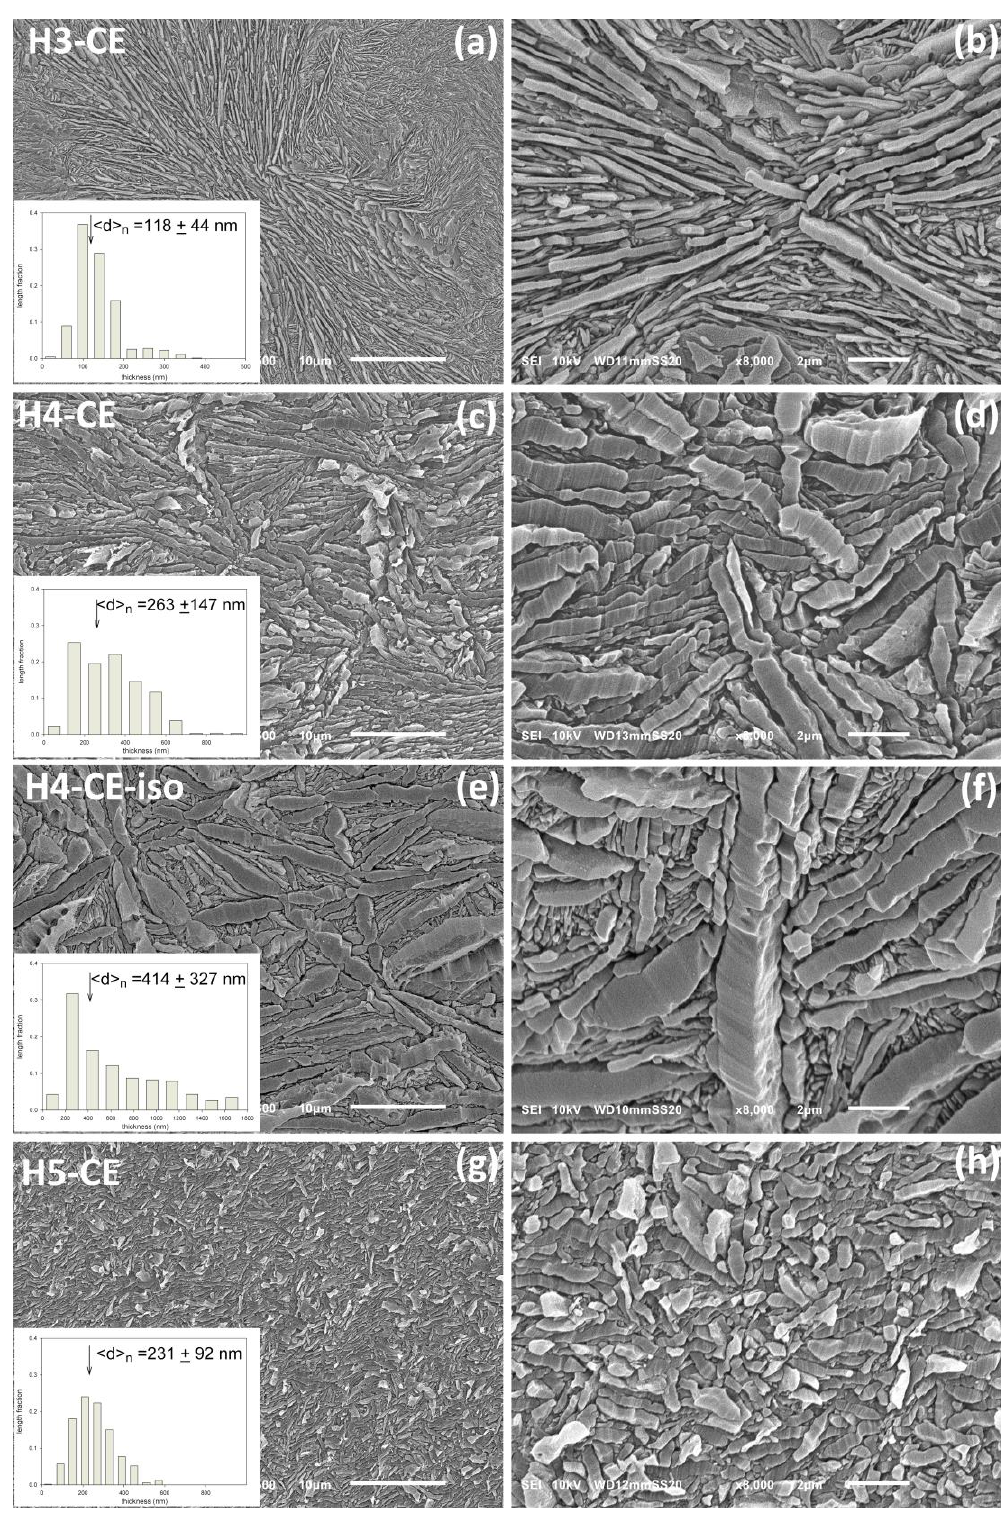
Figure 3. SEM micrographs of non-deformed CEPE samples etched with permanganic etchant: ( a , b ) — H3-CE, ( c , d ) — H4-CE, ( e , f ) — H4-CE-iso, ( g , h ) — H5-CE. Micrographs ( a ), ( c ), ( e ) and ( g ) were taken at magnification of 2500, while ( b ), ( d ), ( f ) and ( h ) show the respective samples at higher magnification of 8000. Insets show the lamella thickness distribution evaluated from the SEM micrographs.